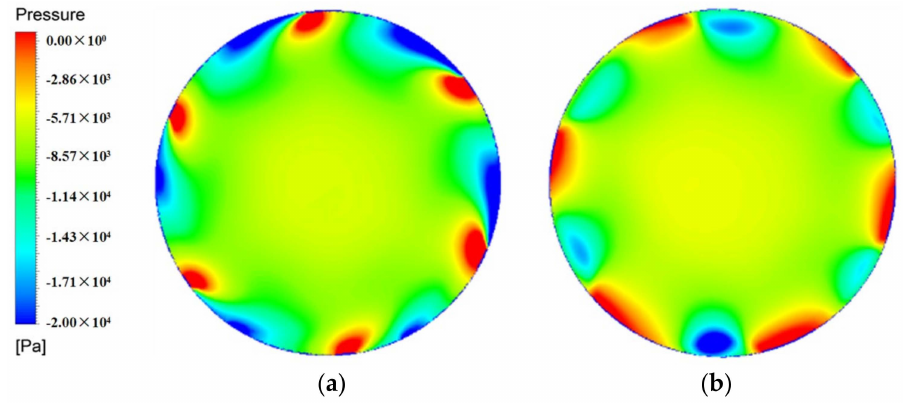
Figure 12. Blade inlet section of 6-blades pump of ( a ) scheme 20 and ( b ) scheme 7.